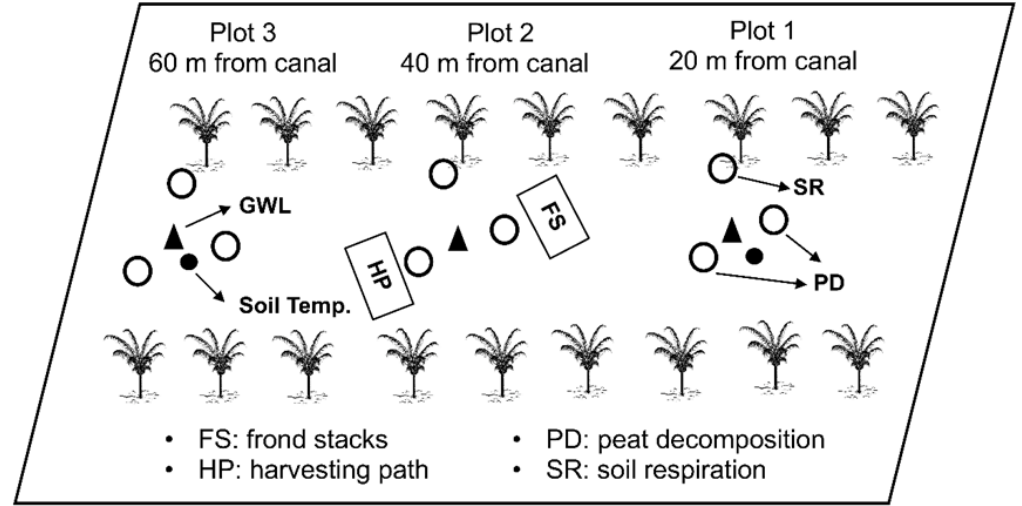
Figure 1. Arrangement of plots, chamber bases and other instruments in relation to plantation